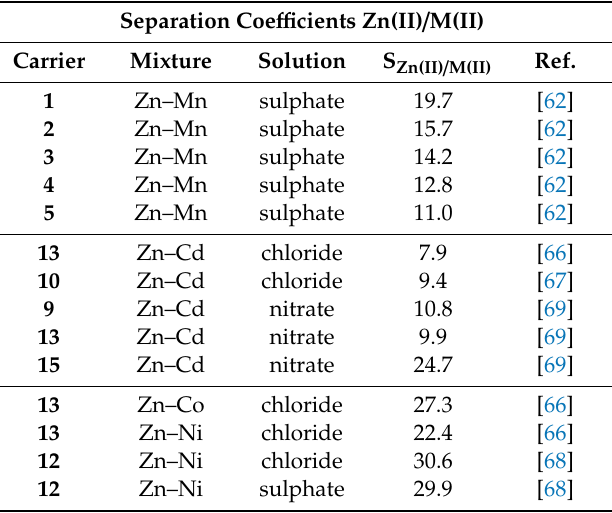
Table 12. Zinc(II) separation coe ffi cients from 2-component equimolar solutions after a 24-h transport.